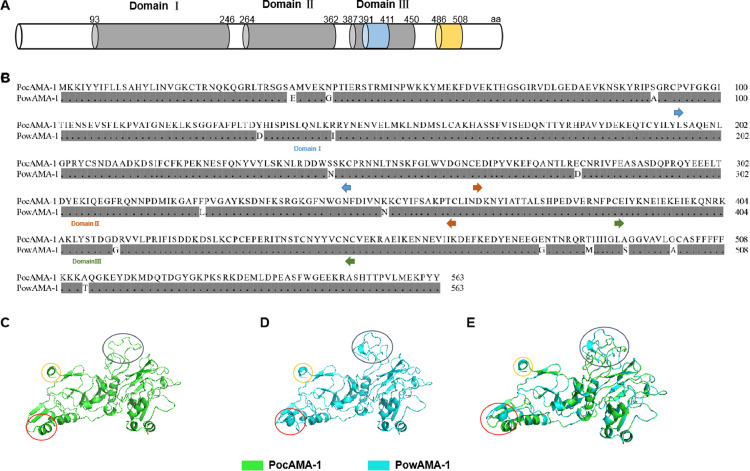
Schematic representation of the protein structure and amino acid sequence alignment of PoAMA-1. (A) Diagram of the protein structure of PoAMA-1. The gray regions are AMA-1 domains; the blue regions are coiled coil domains; the orange regions are transmembrane domains. (B) Amino acid sequences alignment between PocAMA-1 and PowAMA-1. Gray area indicates that the aligned amino acid is identical to the target amino acid. (C) Tertiary structure model of PocAMA-1 protein. (D) Tertiary structure model of PowAMA-1 protein. (E) Tertiary structure model of PoAMA-1 protein. These models are shown in different colors; the PocAMA-1 structure is shown in green, and the PocAMA-1 structure is shown in blue. The tertiary structure of PocAMA-1 and PowAMA-1 mainly has three different areas, which are marked with red, yellow, and black.